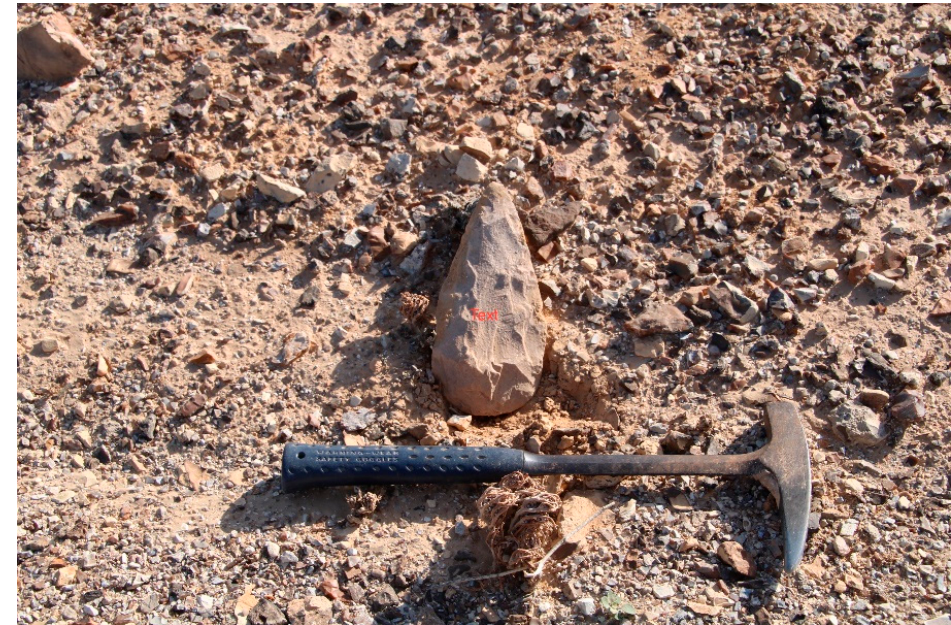
Figure A1. Lower Palaeolithic biface lying on a bare gravel surface, western Sahara.